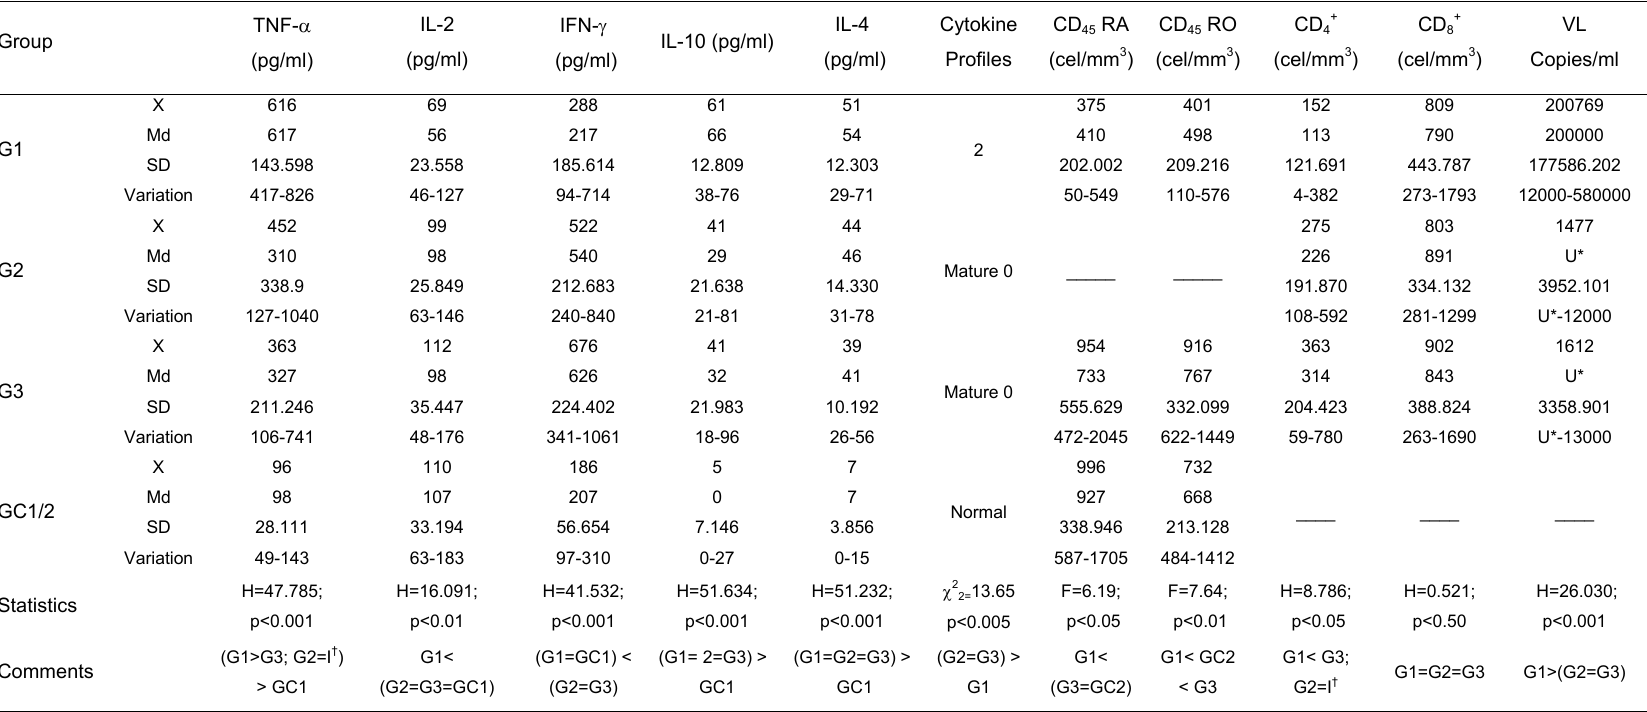
Table 4: Distribution of the 37 HIV-1 infected individuals and 49 normal controls by group, according to TNF- α , IFN- γ , IL-2, IL-4, and IL-10 serum cytokines, cytokine profile, CD and plasma viral load